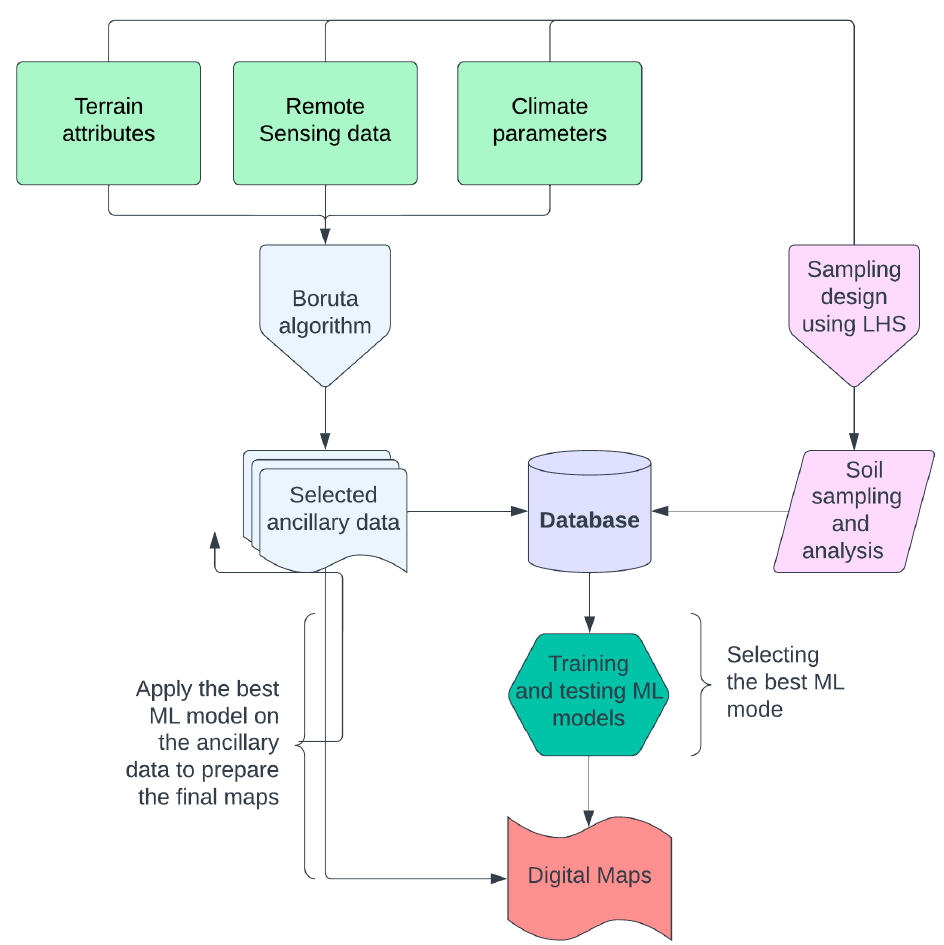
Figure 1. Overview of employed methods.